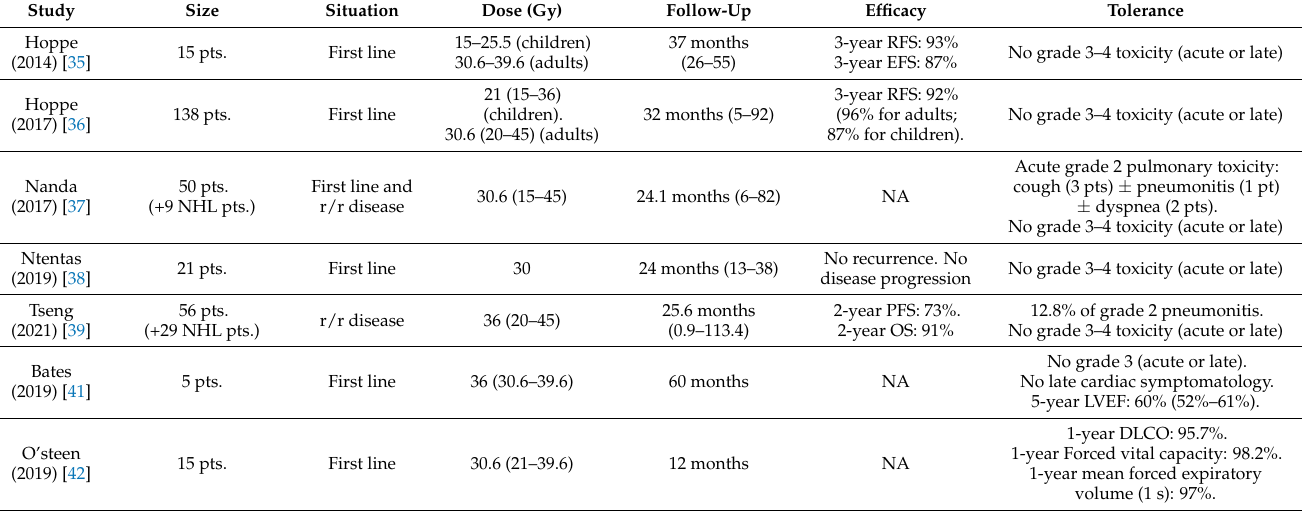
Table 1. Published clinical data (2014–2021) on radiation exposure to organs-at-risk for Hodgkin lymphoma (HL) patients treated with proton therapy. Nanda et al. [37] and Tseng et al. [39] included non-Hodgkin lymphoma (NHL) patients in their studies. Pts.: patients. r/r: relapse refractory. RFS: relapse-free survival. EFS: event-free survival. OS: overall survival. LVEF: left ventricle ejection fraction. DLCO: diffusing capacity of lung for carbon monoxide.